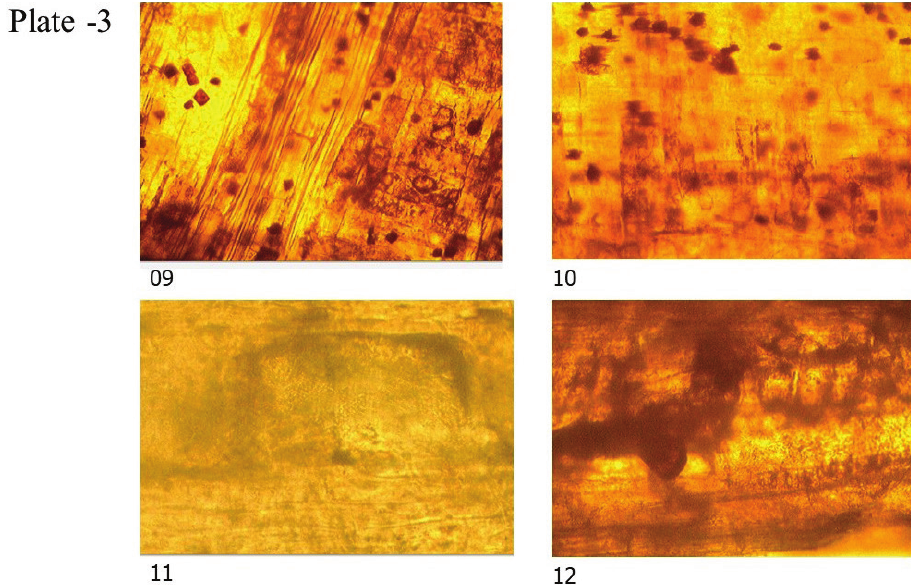
Figure 4. Atalantioxylon thanobolensis sp. nov. Plate 3-09 Radial longitudinal section showing arrange- ment of fibers (×40). Plate 3-10 Radial longitudinal section showing arrangement of fibers (×40). Plate 3-11 Radial longitudinal section showing vessel end-walls and pits (×200). Plate 3-12 Radial longitudinal section showing pits on wall of vessels